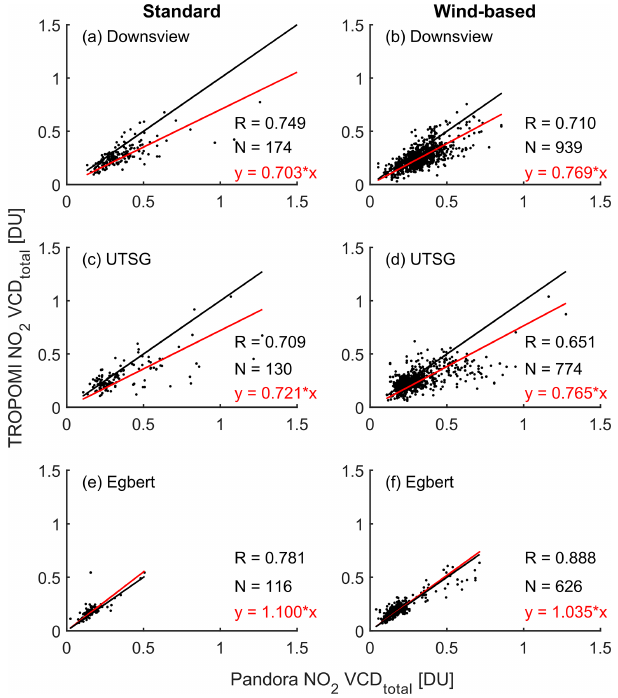
Figure 4. TROPOMI (KNMI) vs. Pandora NO 2 total columns mea- sured at Downsview, UTSG, and Egbert, using the standard (a, c, e) and wind-based (b, d, f) coincidence comparison methods. In each scatter plot, the red line is the linear fit with the intercept set to 0, and the black line is the one-to-one line.